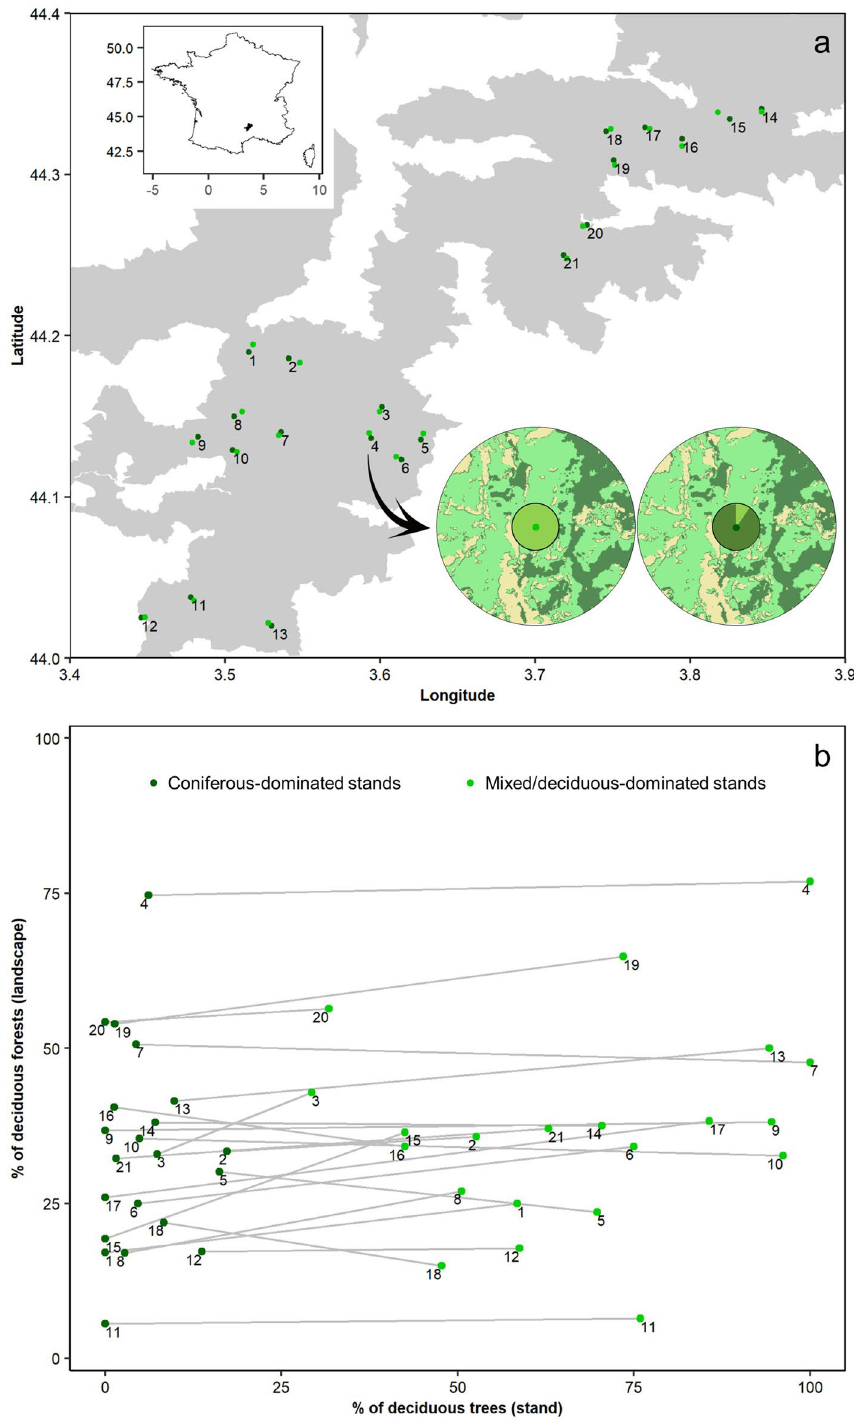
Figure 3. Study design. ( a ) Location of the 21 paired stands in the Cévennes Biosphere Reserve and National Park. Each number represents a pair of one coniferous-dominated stand and one mixed/deciduous-dominated stand. The core zone of the study area is represented in grey. Schematic representation (not in scale) of the land cover within 1-km radius buffer of one pair is depicted (dark green: coniferous forests; olive green: deciduous forests; beige: others) with a pie chart at its centre representing the percentage of deciduous trees (light green) vs. coniferous trees (dark green) at the stand scale. ( b ) Distribution of the sampled stands along a gradient of deciduous-conifer mixture at both stand of and landscape levels (see material and methods for more details). Stands of the same pair have the same number and are linked with a grey line. The map was created using ArcGIS v10.2 (ESRI, Redlands, California, USA; https:// deskt op. arcgis. com/ fr/